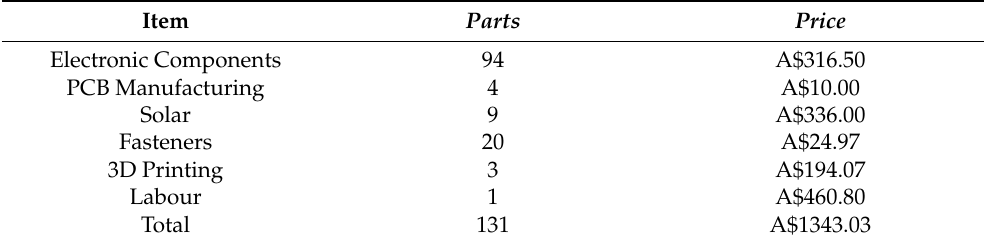
Table 4. Main items and their associated